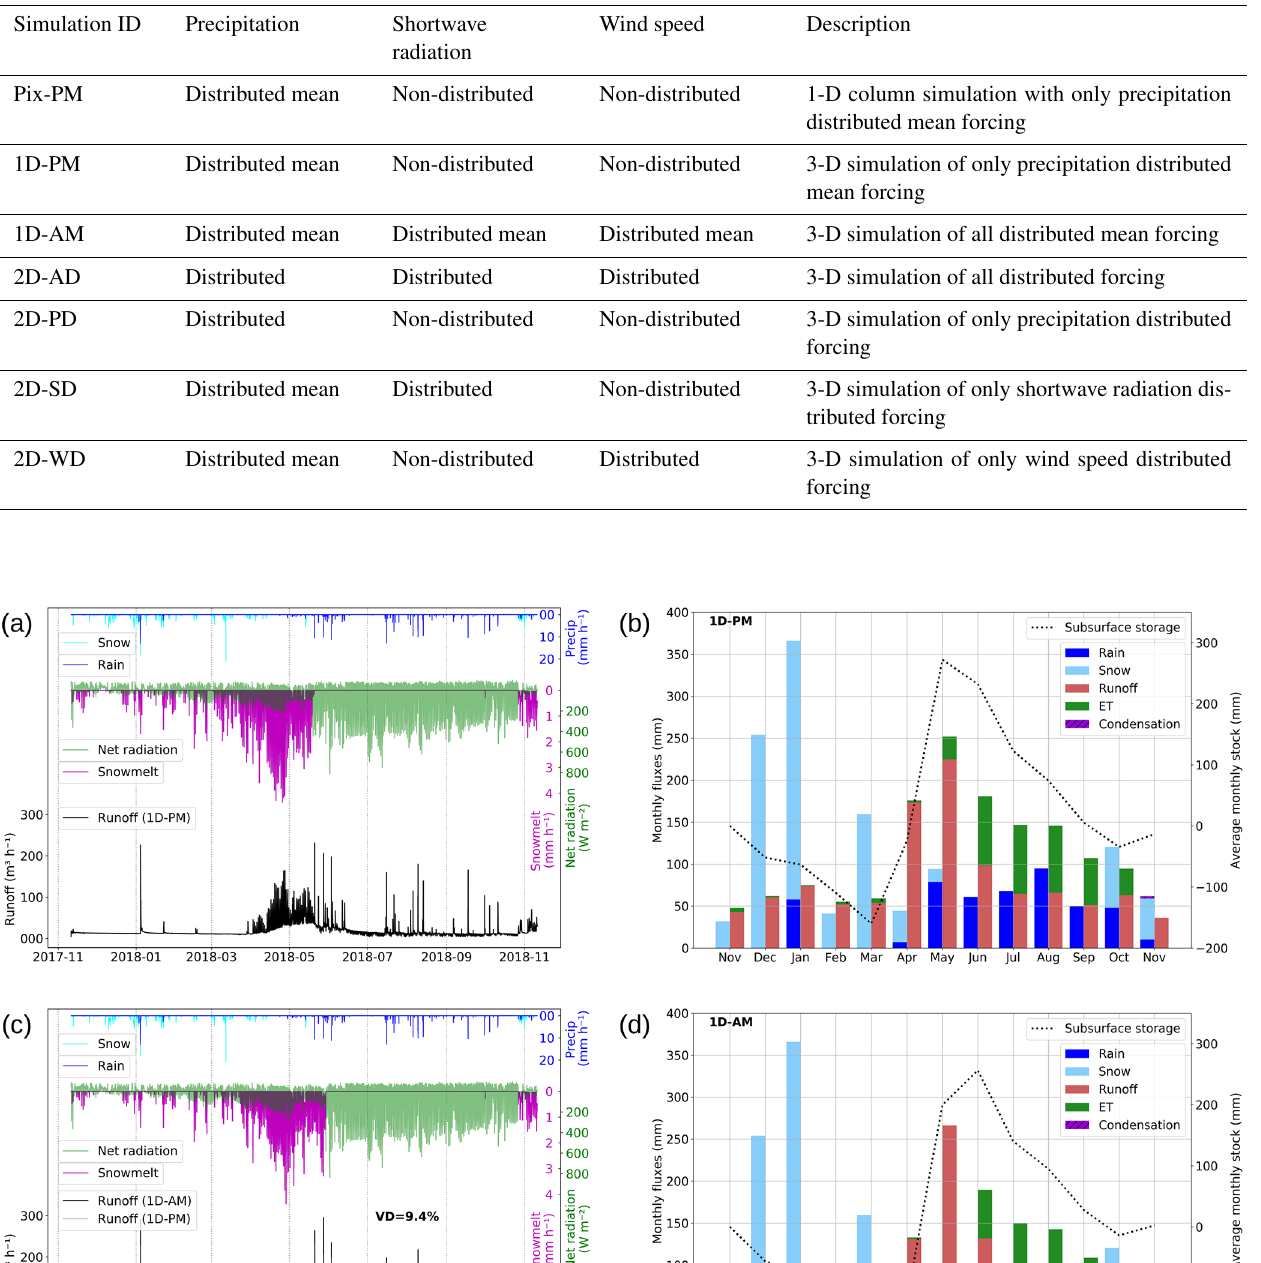
Table 1. Distributed and non-distributed approach adopted for different simulations.